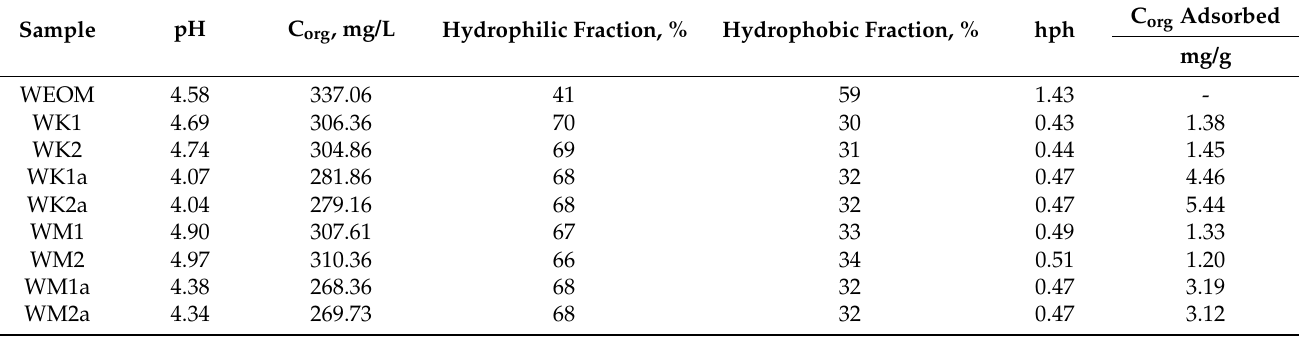
Table 3. WEOM properties before and after adsorption on minerals and the amount of C org